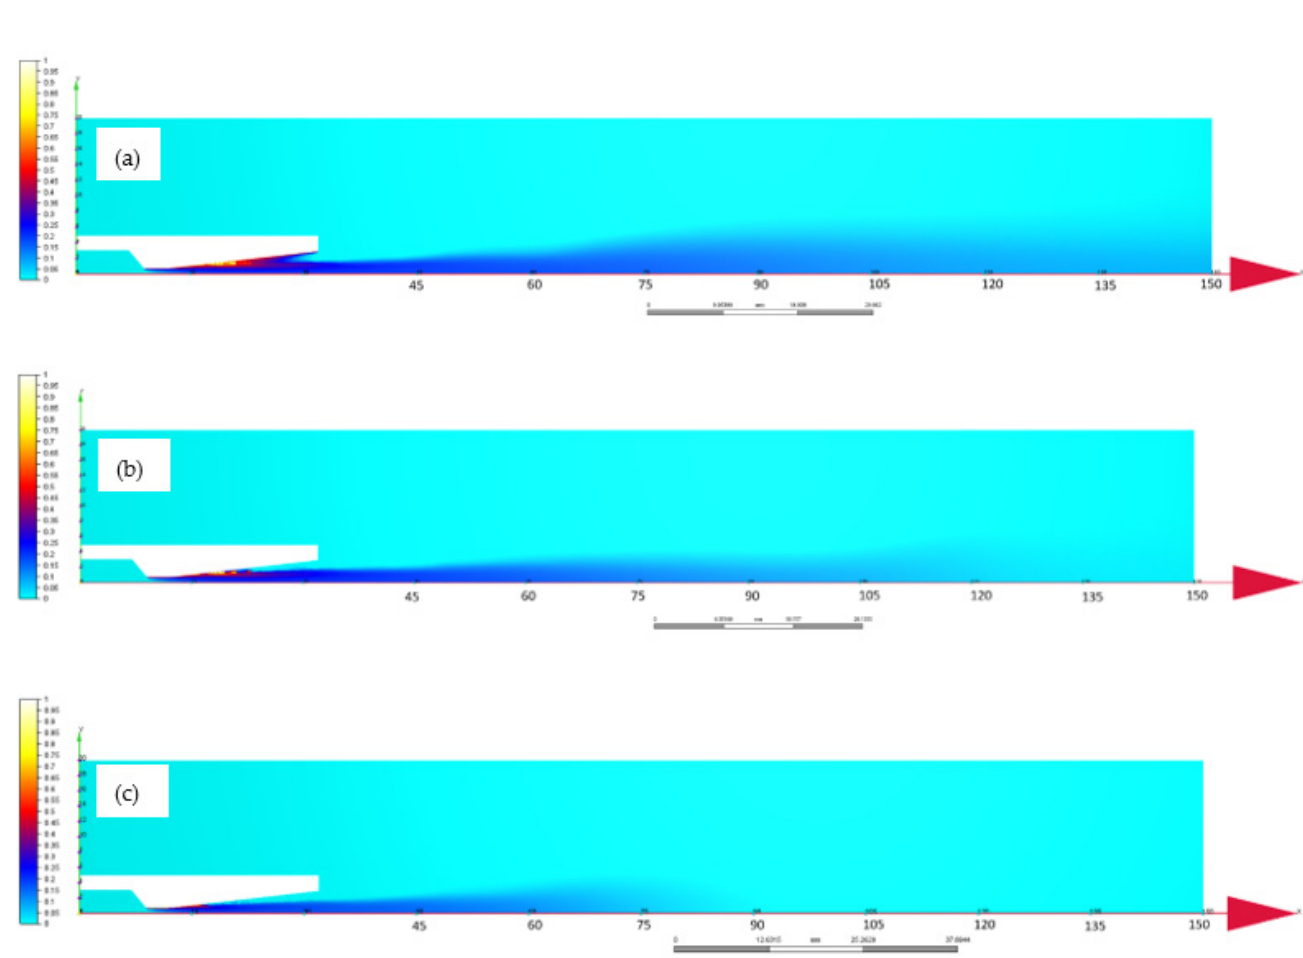
Figure 12. Cavitation vapor volume fraction for cavitation nozzle. P in = 300 atm: ( a ) P out = 0 (gauge), ( b ) P out = 10 atm (gauge), ( c ) P out = 30 atm (gauge).